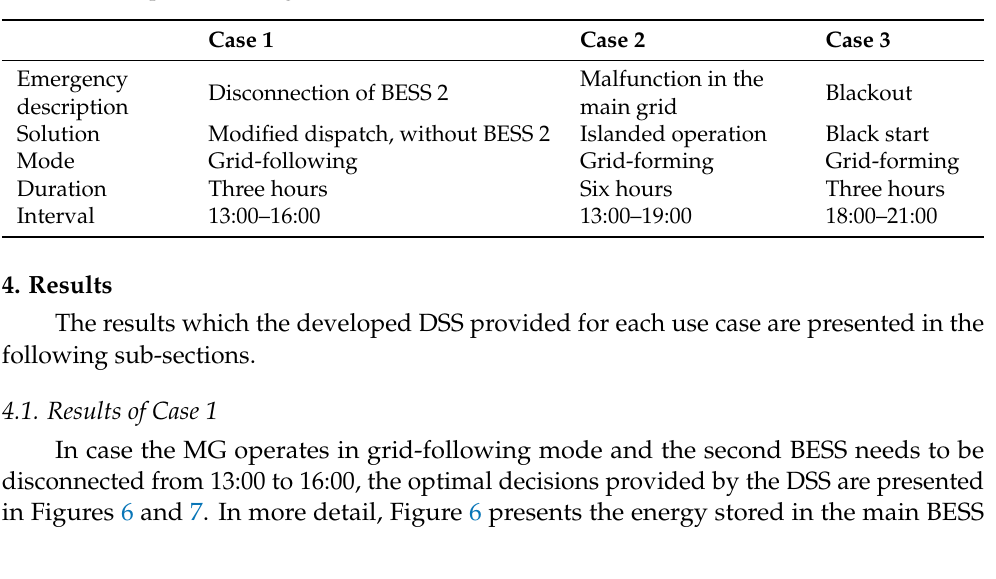
Table 2. Description of